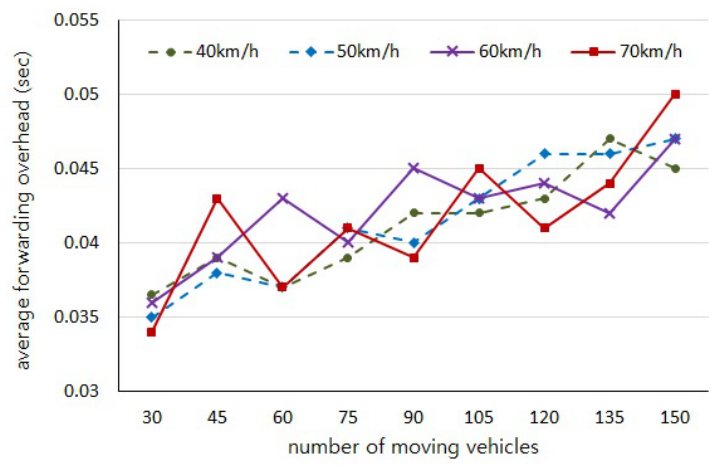
Figure 6. Average forwarding delay ( D auth ) to the number of hops burdened by authentication process.